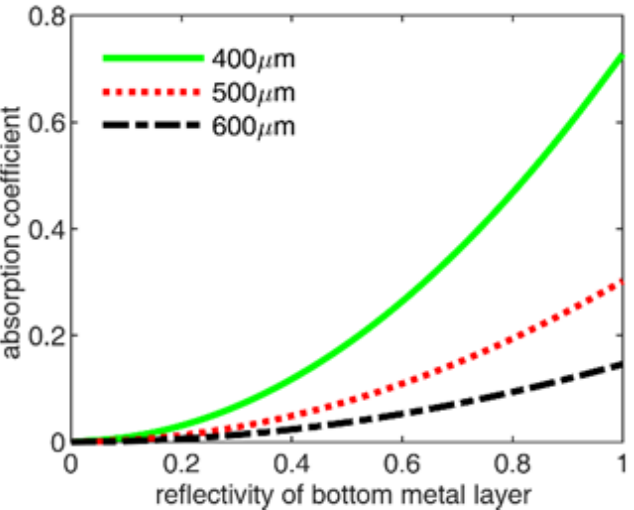
Figure 10. Absorption coefficient under the different reflectivity of the bottom metal layer.